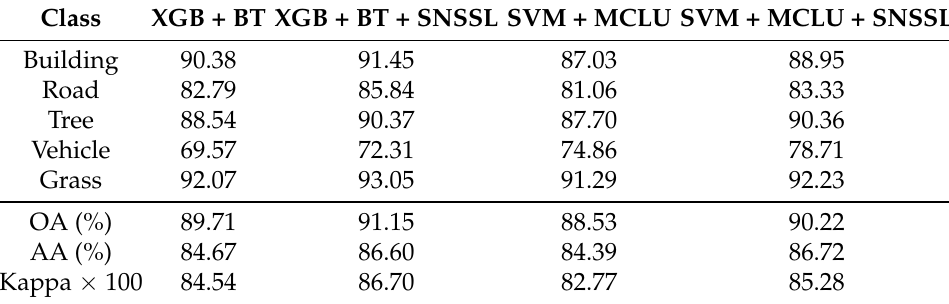
Table 3. Classification accuracy (averaged on 5 runs) of the FloodNet-6651.